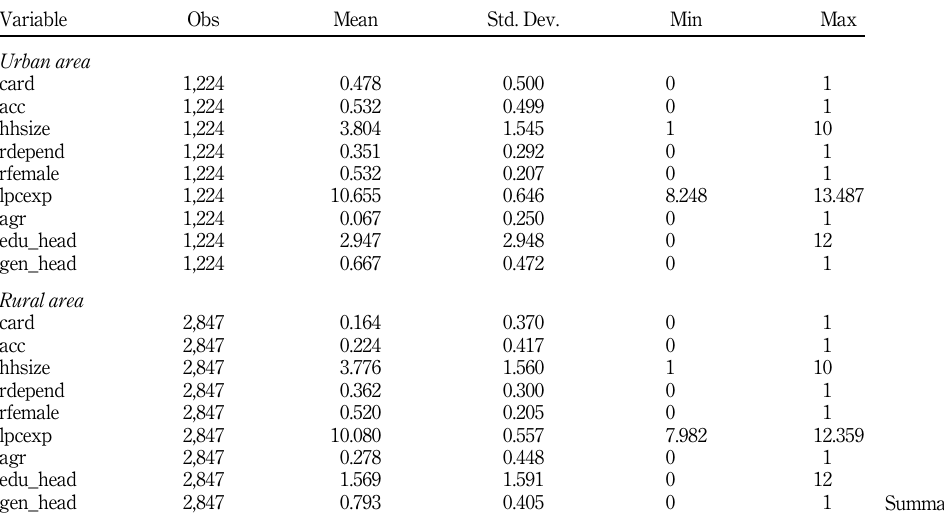
Table A1. Summary of